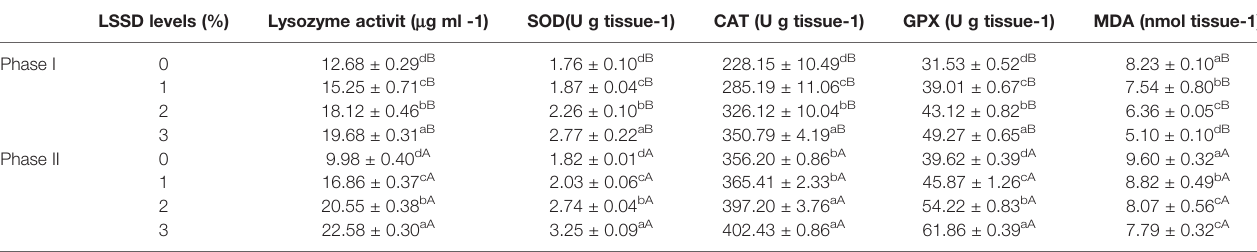
TABLE 7 | Variations in lysozyme activity, superoxide dismutase (SOD), catalase (CAT), and glutathione peroxidase (GPX) activities and malondialdehyde (MDA) value and of Nile tilapia, O. niloticus, fed 0, 1, 2, and 3% diet of L. siceraria seeds supplemented diets (LSSD) for 60 days (Phase I) and after exposure to A. hydrophila (Phase II).